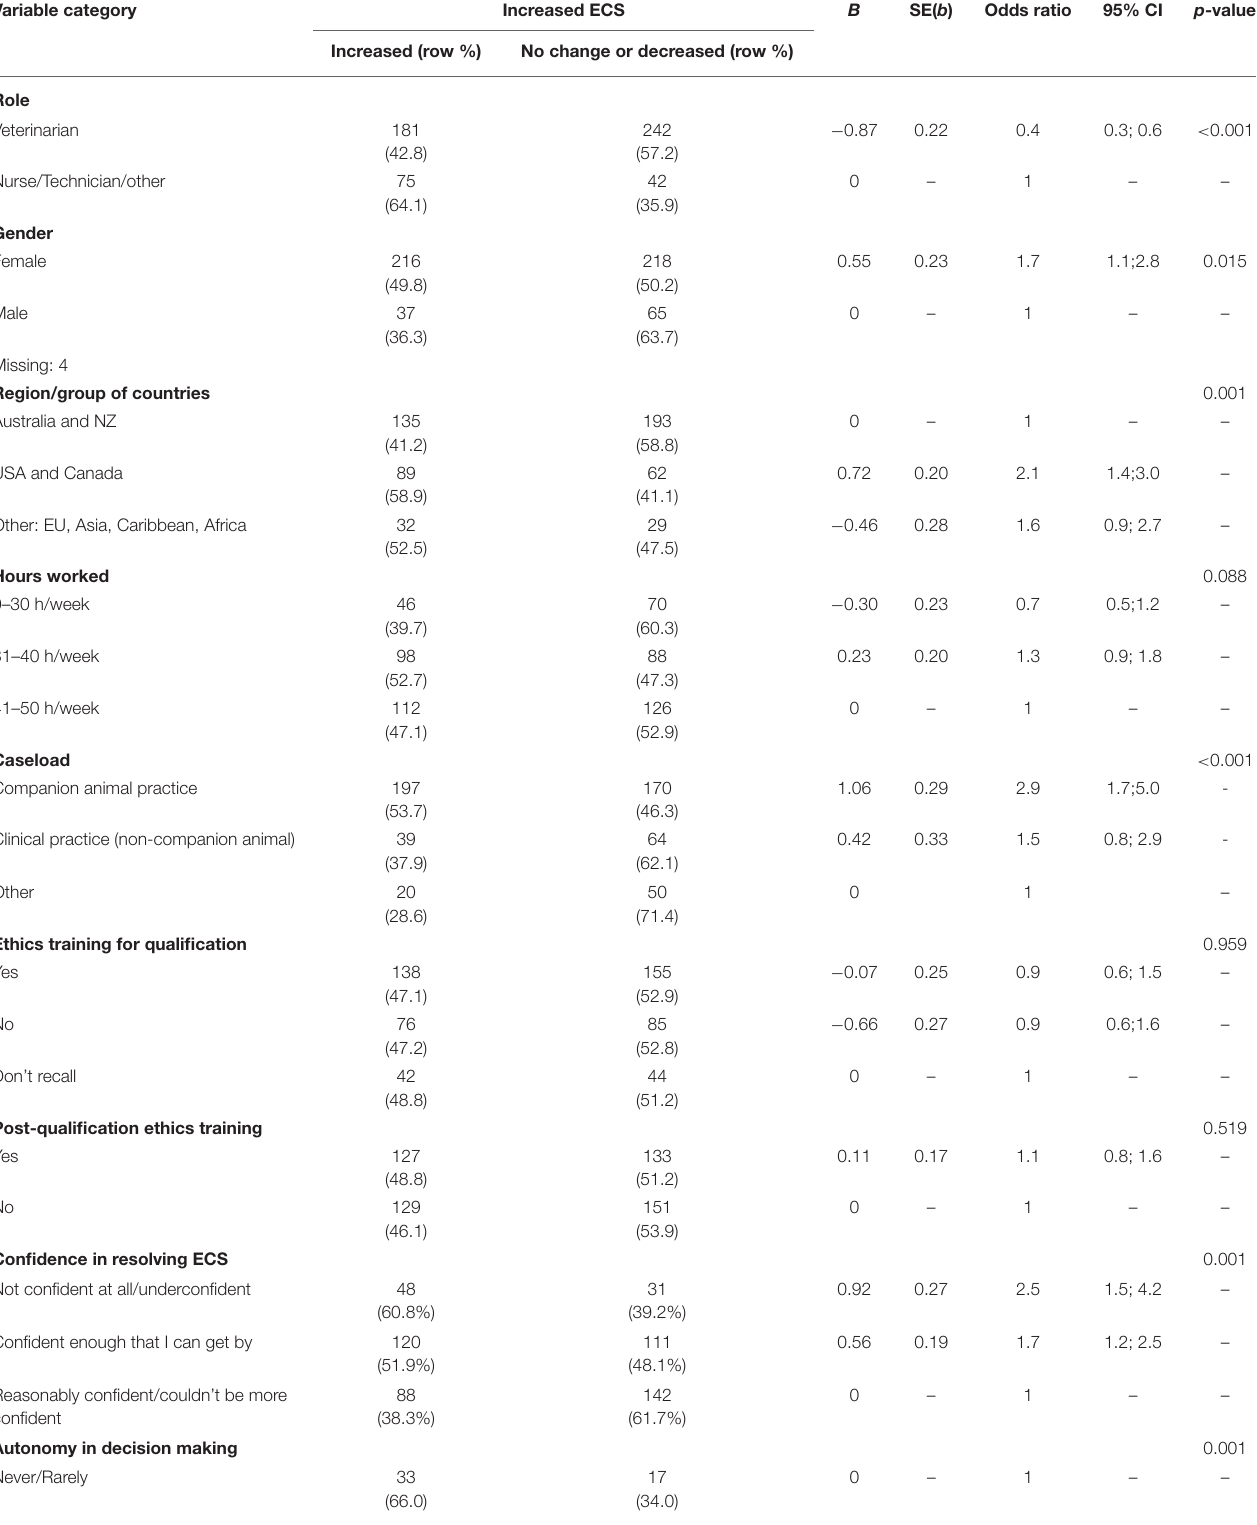
TABLE 3 | Contingency tables and univariable logistic regression results for demographic variables associated with an increase in ethically challenging situations encountered since the beginning of the COVID-19 pandemic, in a global survey of veterinary team members ( n = 540). Variable